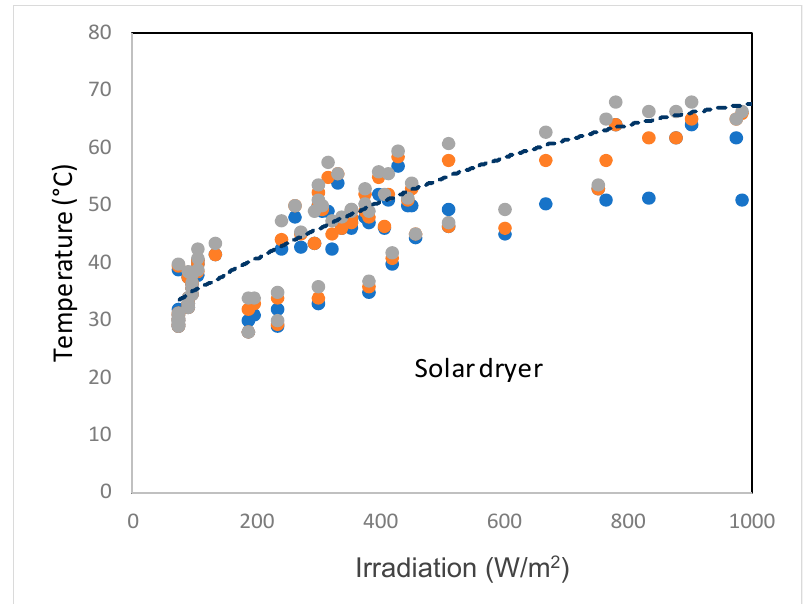
Figure 4. Measurements performed under environmental conditions for the solar dryer.